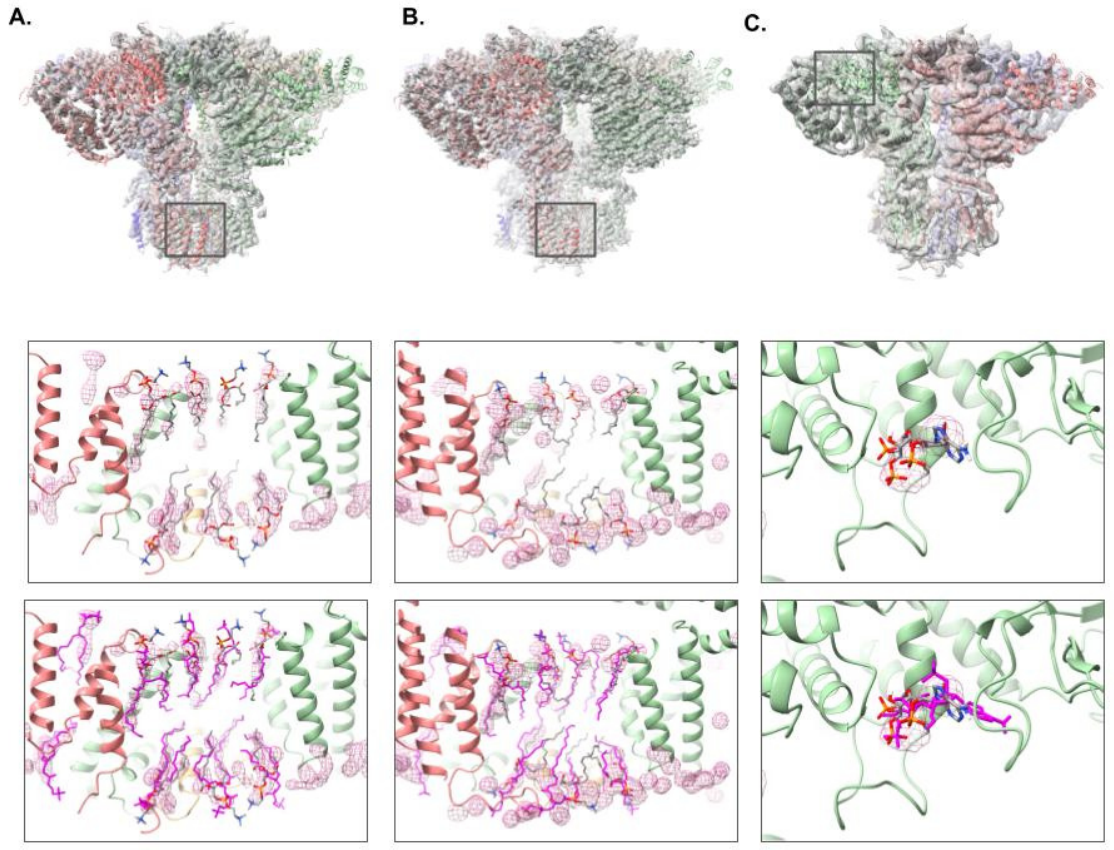
Figure 7. Ligand Identification in IP 3 R1. The Pathwalking models with ligands identified using pw_ligands.py from three different IP 3 R1 reconstructions are shown, Results from the 3.3 Å and 2.96 Å IP 3 R1 reconstructions are shown in ( A ) and ( B ), respectively. In ( C ), the 4.1 Å reconstruction of IP 3 R1 contains the ligand, adenophostin A (ADA). The identified ligand density and lipids are shown in the middle panel, while the model for the published structure (magenta) is shown in the lower panel. A zoomed-in view of the identified ligand region, marked with a square in the top row, can be seen in the middle panel. In all three of the models, only a single set of lipids are shown per tetramer. While phosphatidylcholine molecules were not previously detected in the 4.1 Å resolu- tion density map of IP 3 R1, the reconstruction did contain adenophostin A (ADA) in the IP